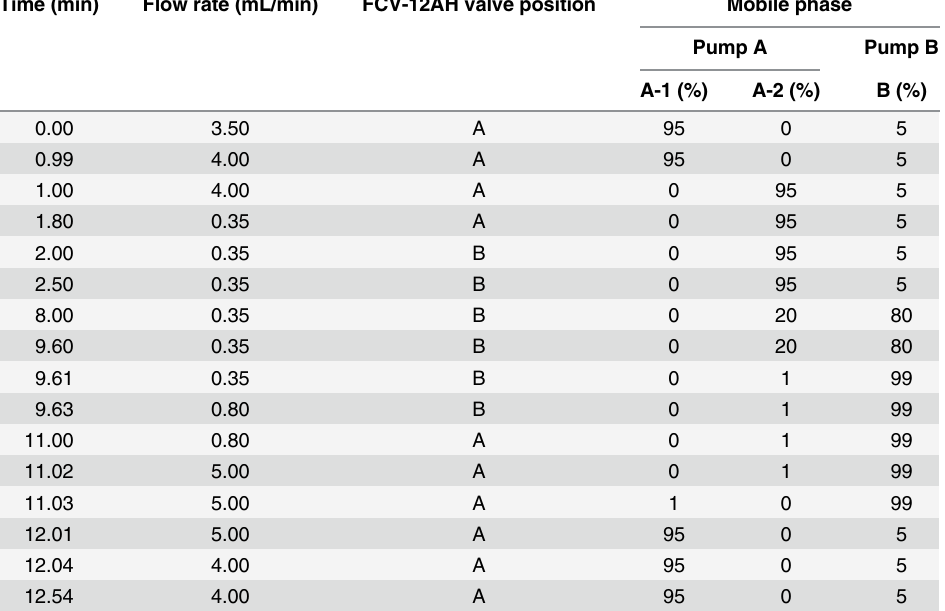
Table 1. Liquid chromatography conditions used for the On-line Solid-Phase Extraction liquid-chro- matography tandem mass spectrometry analysis. Time (min) Flow rate (mL/min)